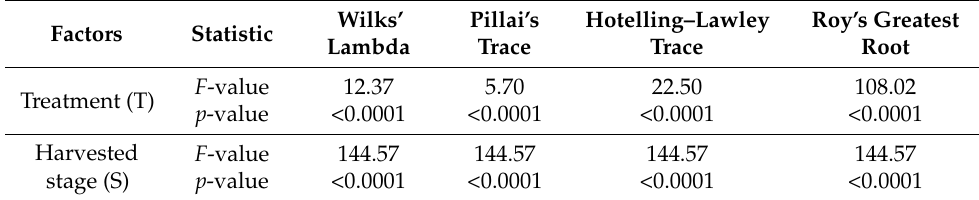
Table 6. Multivariate Analysis of Variance (MANOVA) test criteria and F approximations for the hypothesis of no overall rffects of the factors. H = Type III SSCP matrix for the treatment and the harvested stage. NOTE: F Statistic for Roy’s greatest root is an upper